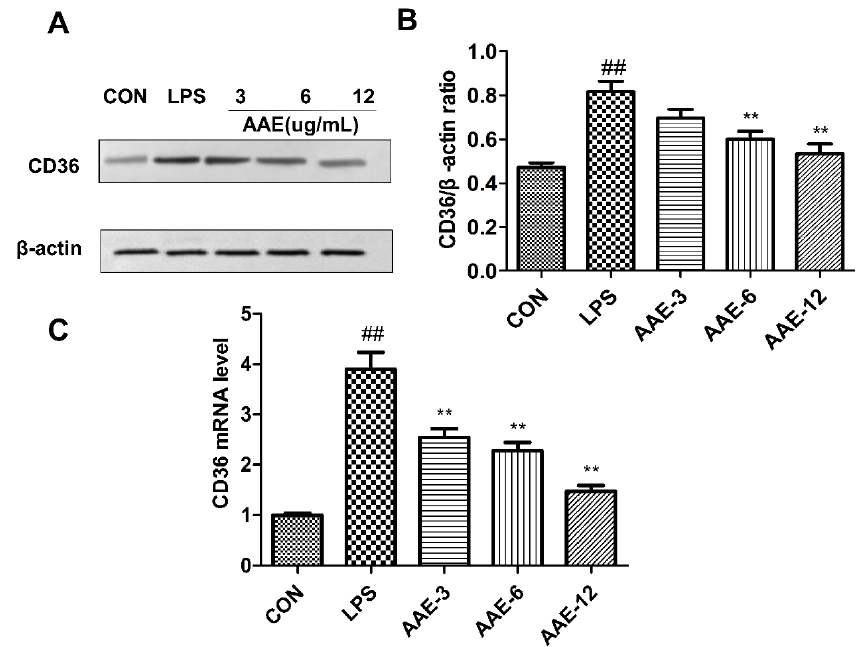
Figure 7. AAE reduced the expression of CD36 in bMECs induced by LPS. Cells were treated with various concentrations (3, 6, 12 μ g/mL) of AAE or medium without serum for 3 h before stimulation with 10 μ g/mL LPS for 12 h. ( A ) Western blotting analysis was performed to test CD36 protein level; β -actin was used as endogenous control. The complete Western blotting images are shown in Figure S2. ( B ) Relative protein expression levels of CD36 to β -actin ( n = 3). ( C ) Relative mRNA expression levels of CD36 were measured by quantitative real-time PCR ( n = 6). CON: cells were cultured in medium (serum-free) for 15 h; LPS: cells were cultured in medium (serum-free) for 3 h and then incubated with 10 μ g/mL LPS for 12 h; AAE-3, AAE-6 and AAE-12: cells were treated with 3, 6 and 12 μ g/mL AAE for 3 h before 10 μ g/mL LPS incubation for 12 h. Comparisons among groups were made with ANOVA followed by Duncan’s test. The data are expressed as mean ± SEM. ## p < 0.01 vs. CON. ** p < 0.01 vs. LPS.